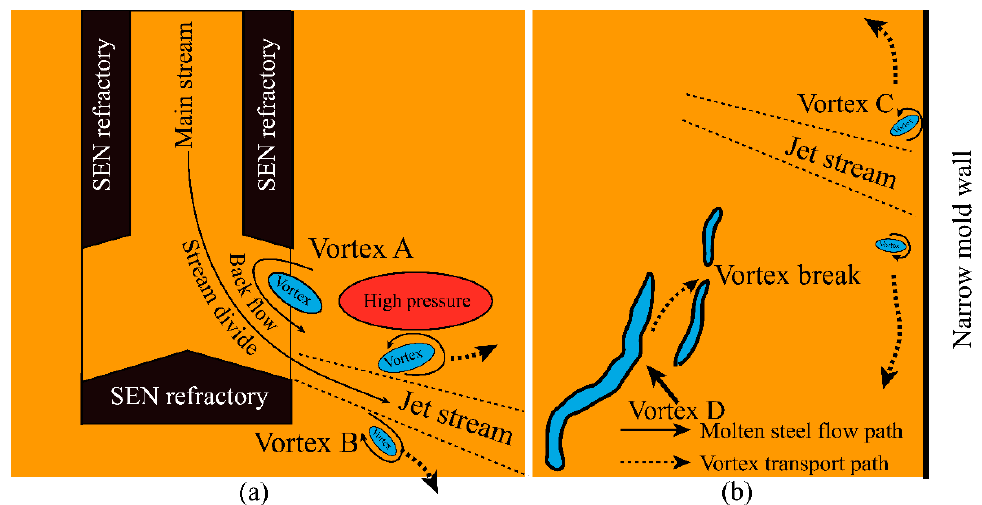
Figure 11. Mechanism of the vortex formation and transportation at ( a ) the SEN ports and the jet stream outside, ( b ) the narrow mold wall and the mold bottom.